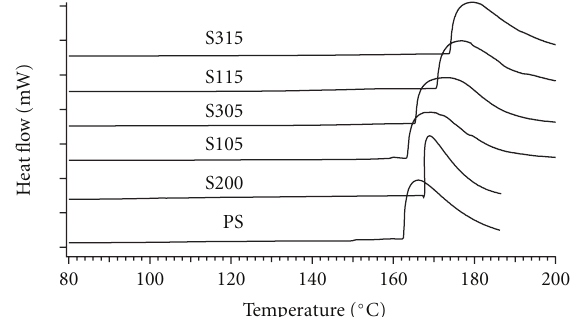
Figure 7: DSC heating curves (heating, endotherm-up) for selected samples with varying nanoclay and sorbitol content.